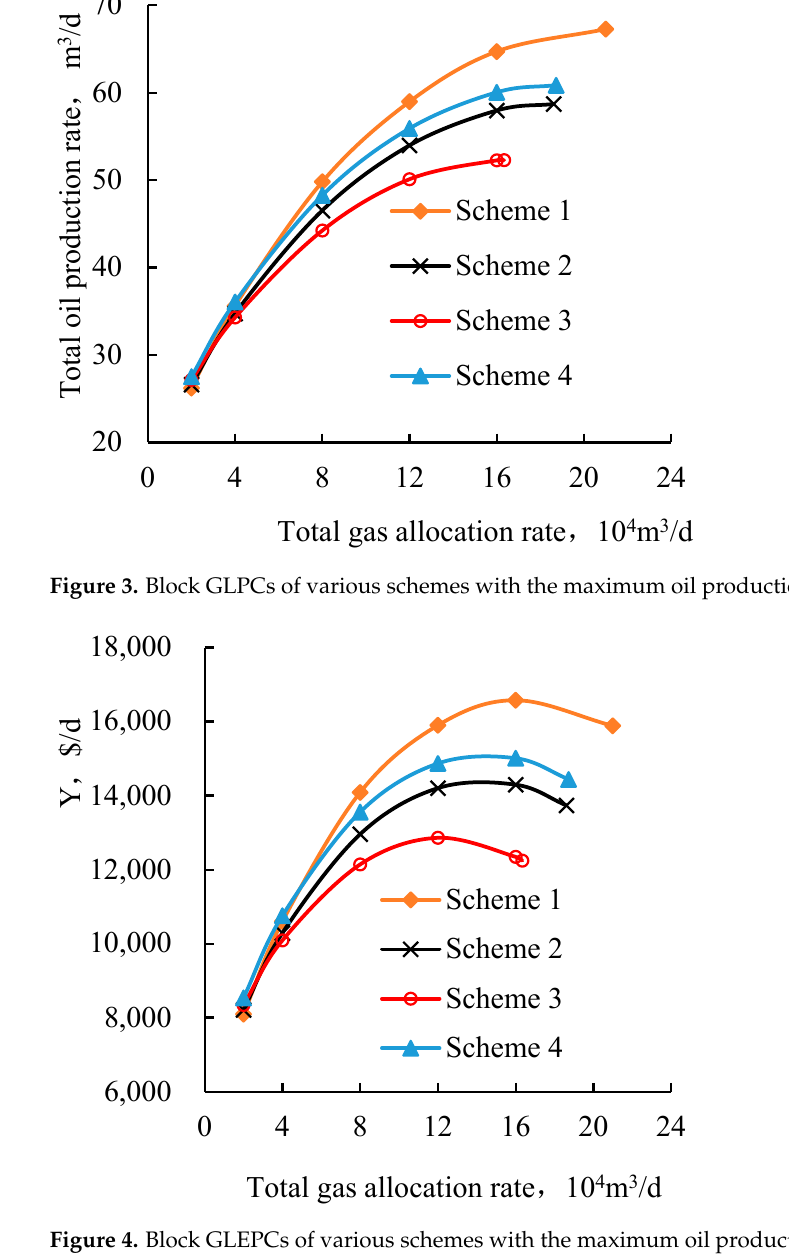
Figure 4. Block GLEPCs of various schemes with the maximum oil production rate. From Tables 4–7 and Figures 3 and 4, it can be concluded that when the gas-lift allocable gas rate is unconstrained, the various gas-lift single wells can be allocated gas according to the optimal injected gas rate of single well (which can be obtained from single well GLPC), and the block optimal gas-lift gas allocation rate is the summation of the optimal injected gas rate of single wells 20.993 × 10 4 m 3 /d. Under the circumstance of considering gas allocation rate as restricted, from the block GLPCs of various schemes it is known that the maximum oil production rate of Scheme 1 is optimal when the allocable gas rate is larger than 5 × 10 4 m 3 /d, and the maximum oil production rate of Scheme 4 is superior to Scheme 1 when the allocable gas rate is smaller than 5 × 10 4 m 3 /d. Therefore, it is necessary to optimize gas lift wells to improve gas-lift production efficiency. The block GLEPC of various schemes indicates that with the total gas allocation rate increasing, the block economic benefits shows the trend of increasing firstly and then decreasing and it start to descend at the time when the gas allocation rate increases to